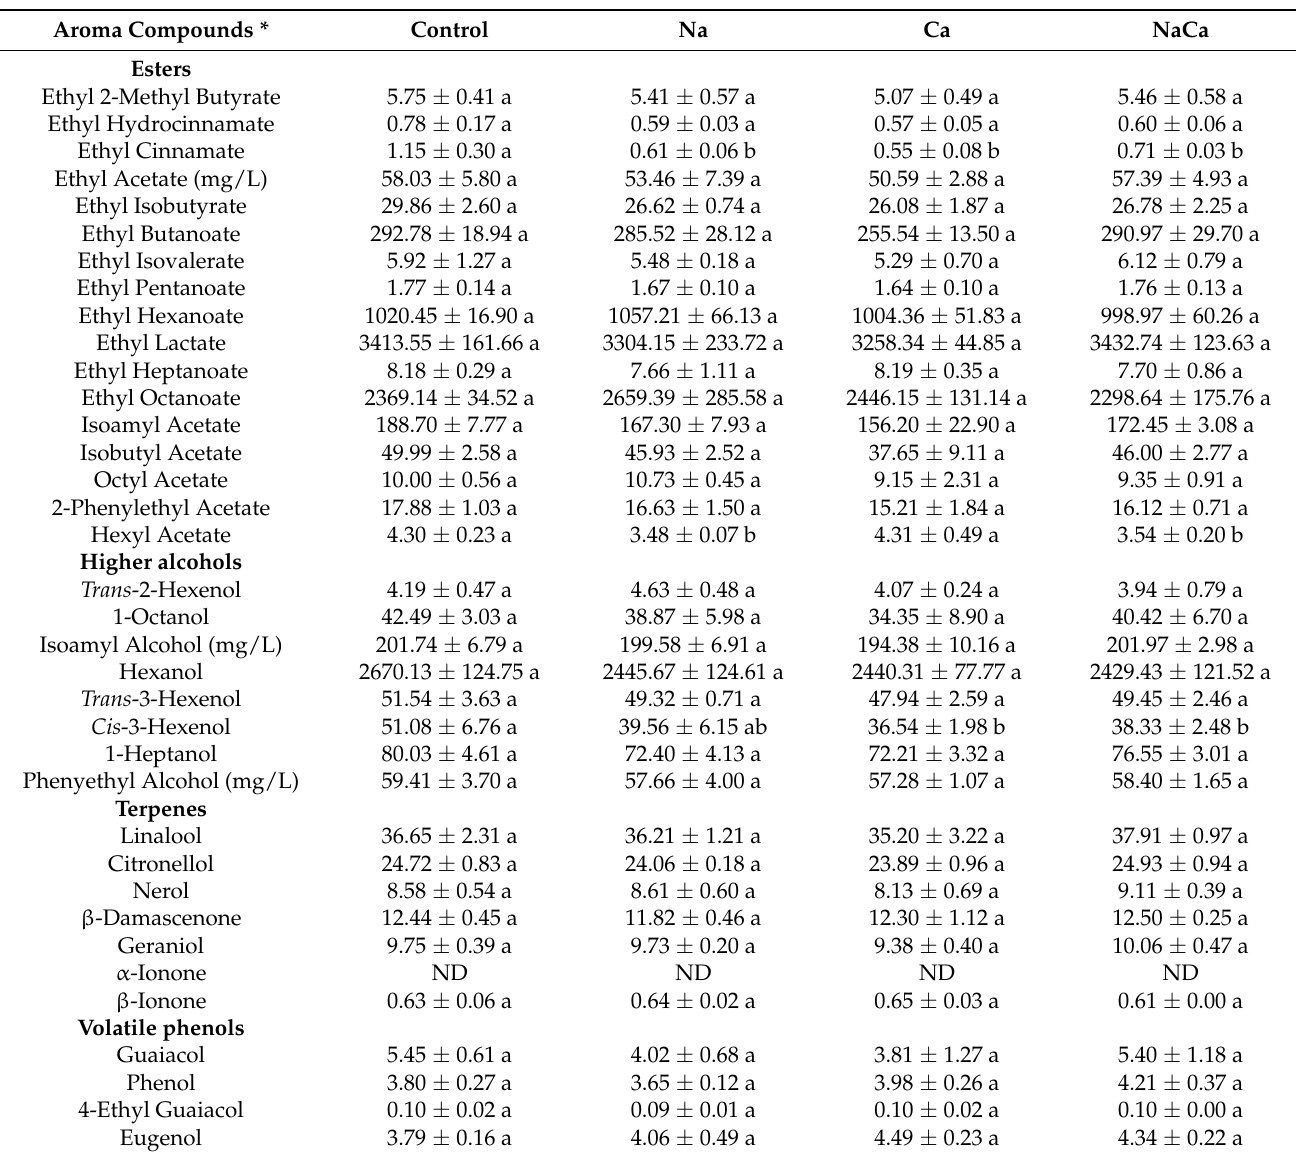
Table 4. Quantification of aroma compounds in resultant Pinot noir